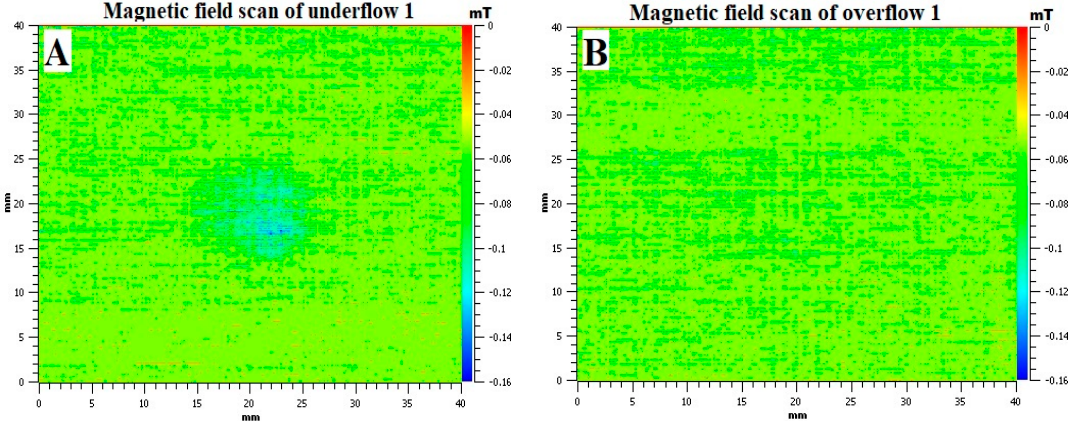
Figure 8. MagScan images of underflow ( A ) and overflow ( B ) after first hydrocyclone pass.